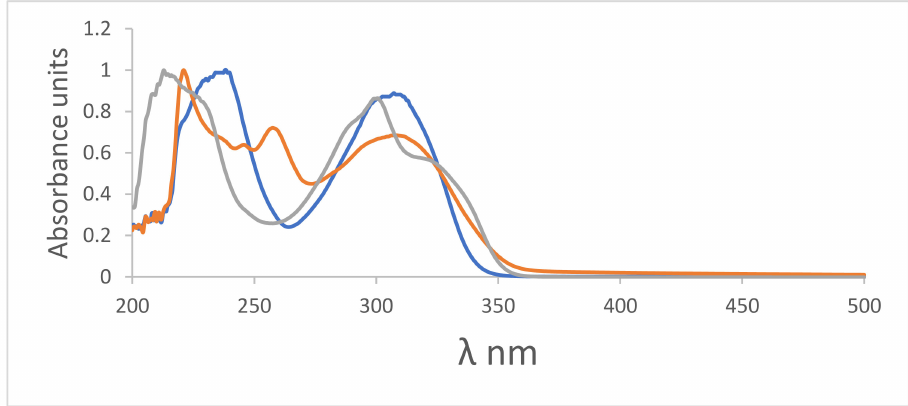
Figure 19. Normalized absorption spectra of 2-amino-4-hydroxy-6-(4-hydroxy-2-oxo-2H-chromen-3- yl)nicotinonitrile 4 6.8 × 10 − 5 M in CH 3 CN, fresh, alkalized using NaOH, and acidified using H 2 SO 4